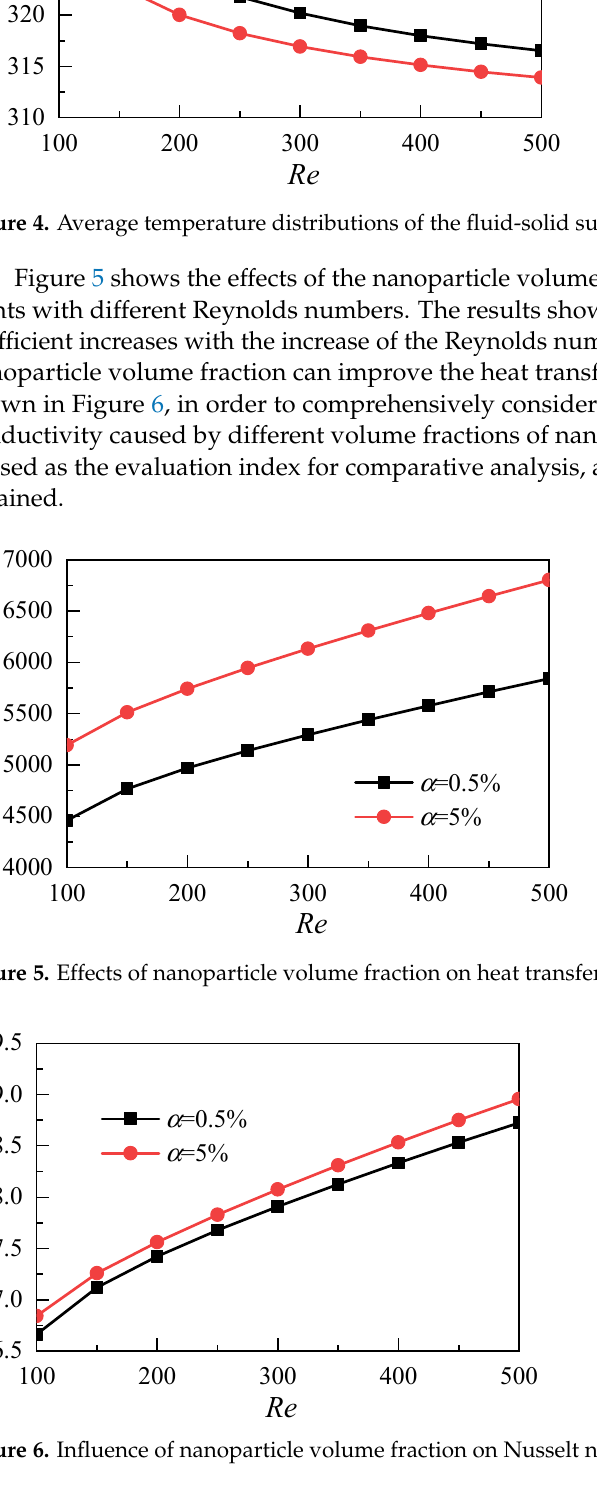
Figure 6. Influence of nanoparticle volume fraction on Nusselt number.